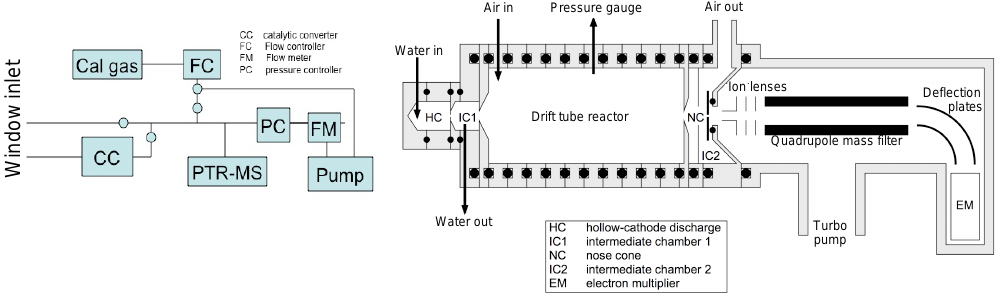
Figure A4. Schematic drawing of the PTR-MS instrument and the inlet.